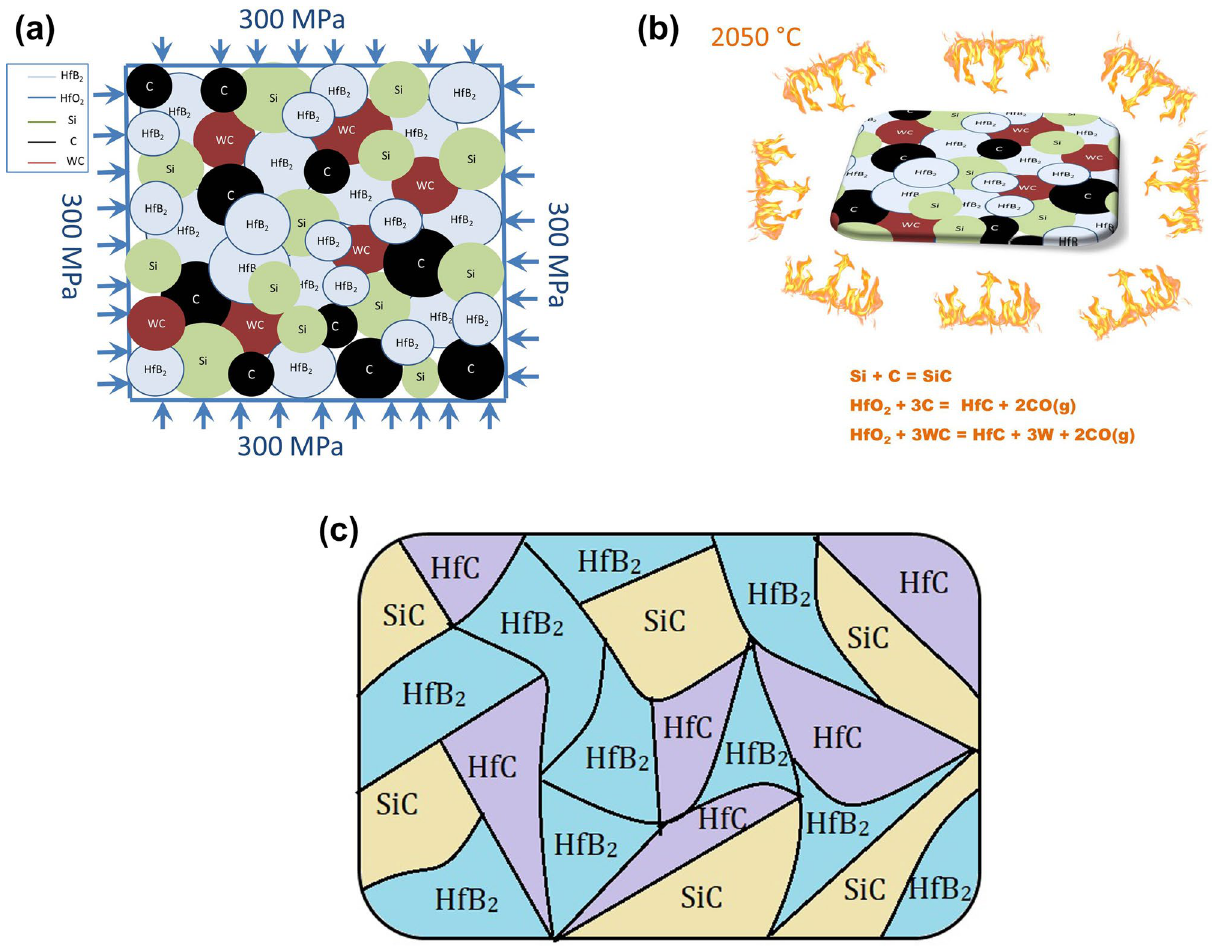
Figure 9. Schematic drawing of the sintering mechanism during reactive consolidation of HfB 2 –SiC composite ( a ) pressing of mixed powders by a cold isostatic press under 300 MPa, ( b ) reaction taking place during sintering process at 2050 °C, and ( c ) final microstructure of the HfB 2 -SiC composite after sintering at 2050 °C including HfB 2 , SiC, and HfC